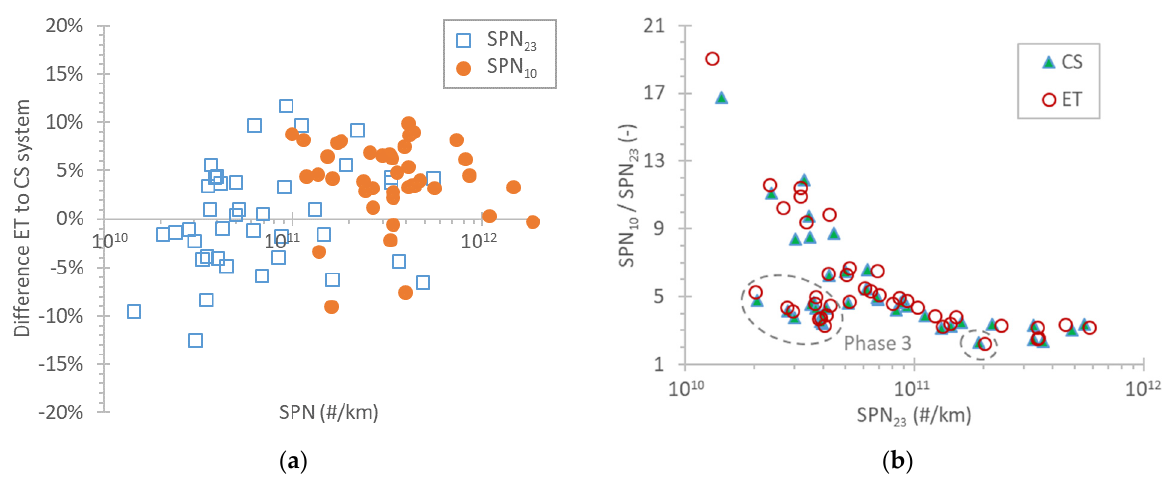
Figure 5. Comparisons of evaporation tube (ET) and catalytic stripper (CS) systems. Each point is a phase of the WMTC (see Figure A1 for cycle and its phases): ( a ) Differences of the two systems in function of emissions levels; ( b ) Ratio of SPN 10 /SPN 23 for the two systems. SPN = solid particle number. WMTC = World Harmonized Test Cycle.